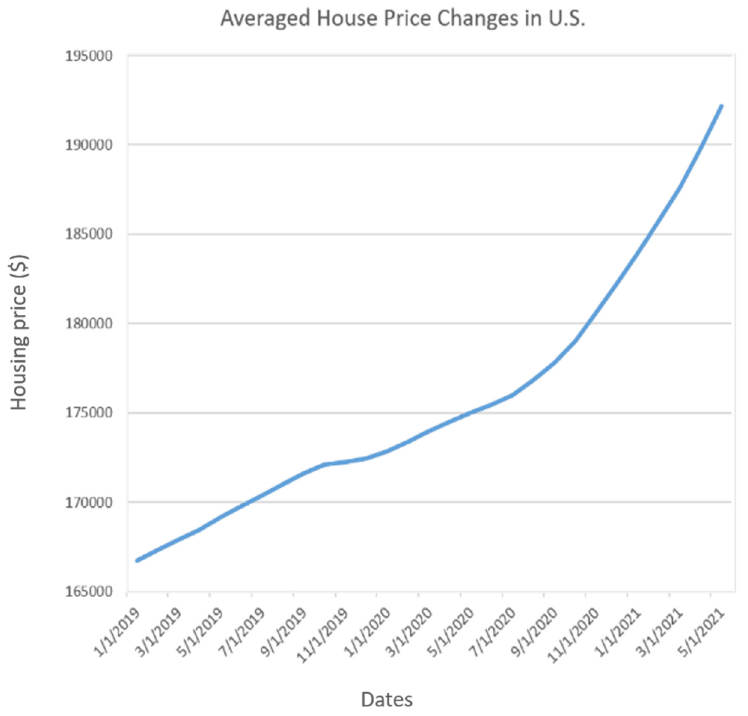
Figure 1. Averaged housing price changes from 1 January 2019 to 31 May 2021.